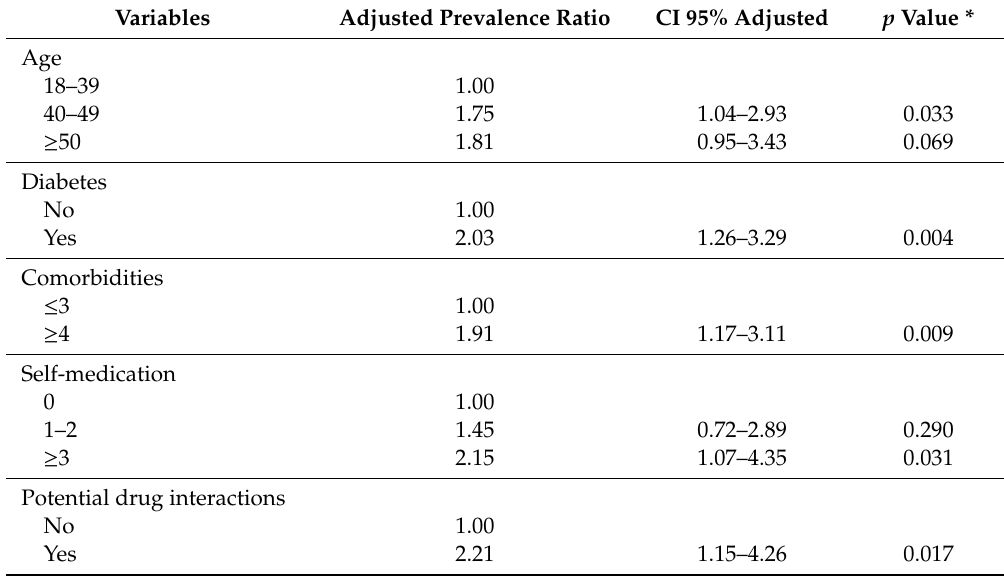
Table 4. Multiple regression of possible factors associated with adverse drug events in severely obese adults ( n =